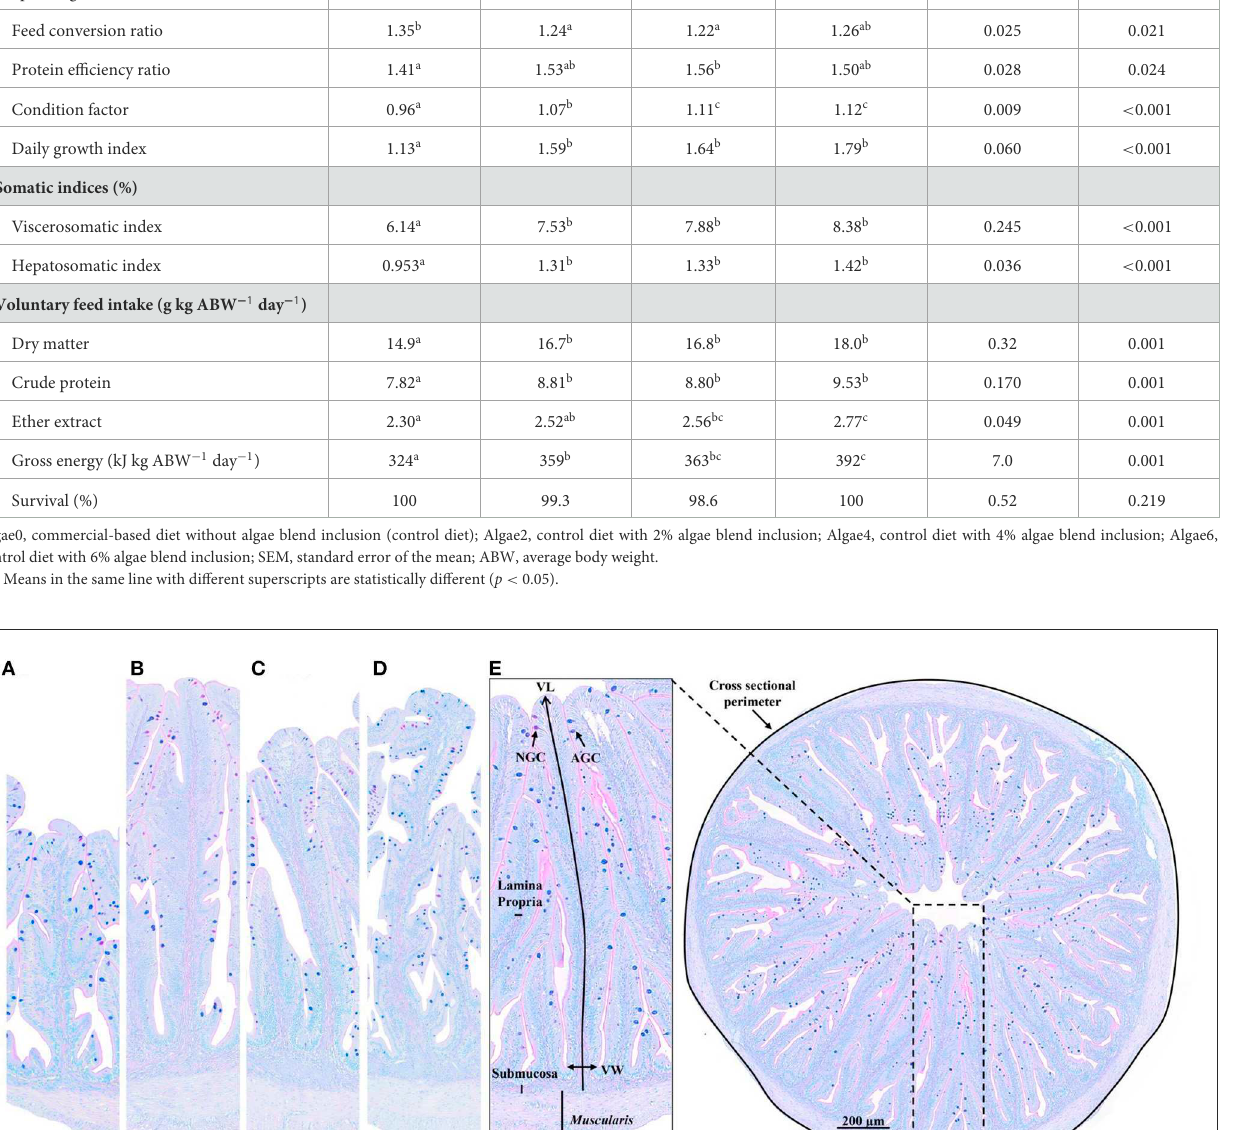
diets. Conversely, C20:1 n -9 and C20:1 n -11 decreased with algae blend inclusion compared to Algae0. Dietary inclusion of the algae blend decreased the proportions of all individual n -6 PUFA,